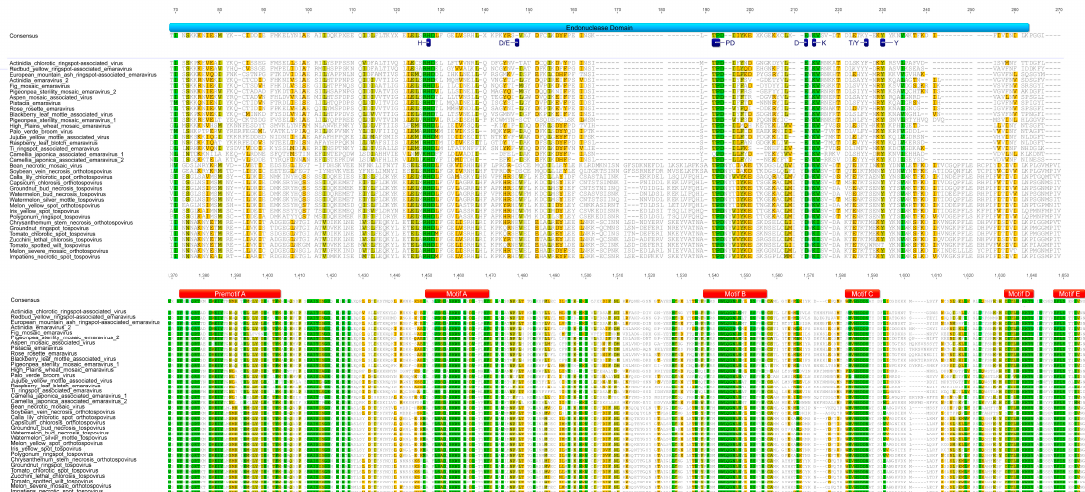
Figure 2. Amino acid alignment showing conserved motifs of the RdRp within Fimoviridae and Tospoviridae. ( A ). The endonuclease domain is indicated by pink bar and active site motifs are identified in blue. ( B ). The polymerase function motifs are named in the red bars as preA motif through E motif. The alignment colored based on the sequence